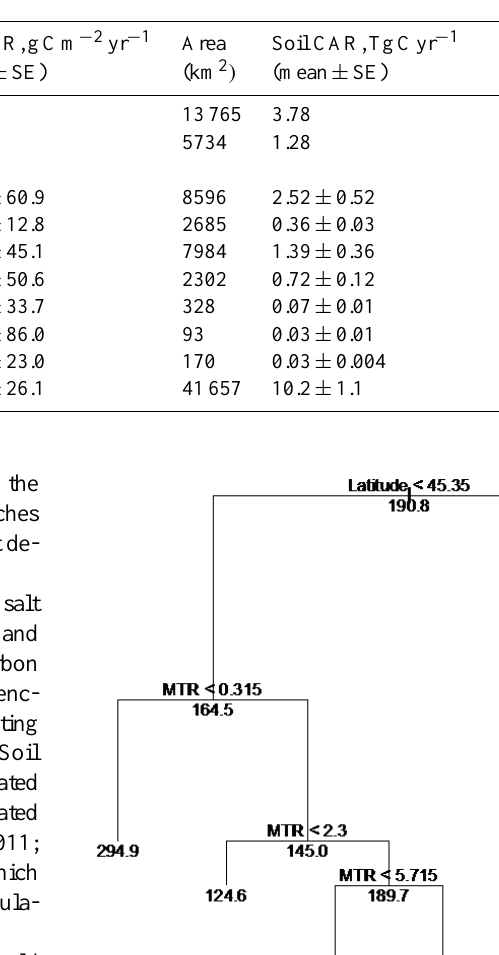
Table 4. Estimation of global CAR using specific soil CAR for different regions. USA was divided into three sub-groups as per the division of salt marsh groups in Fig. 1.